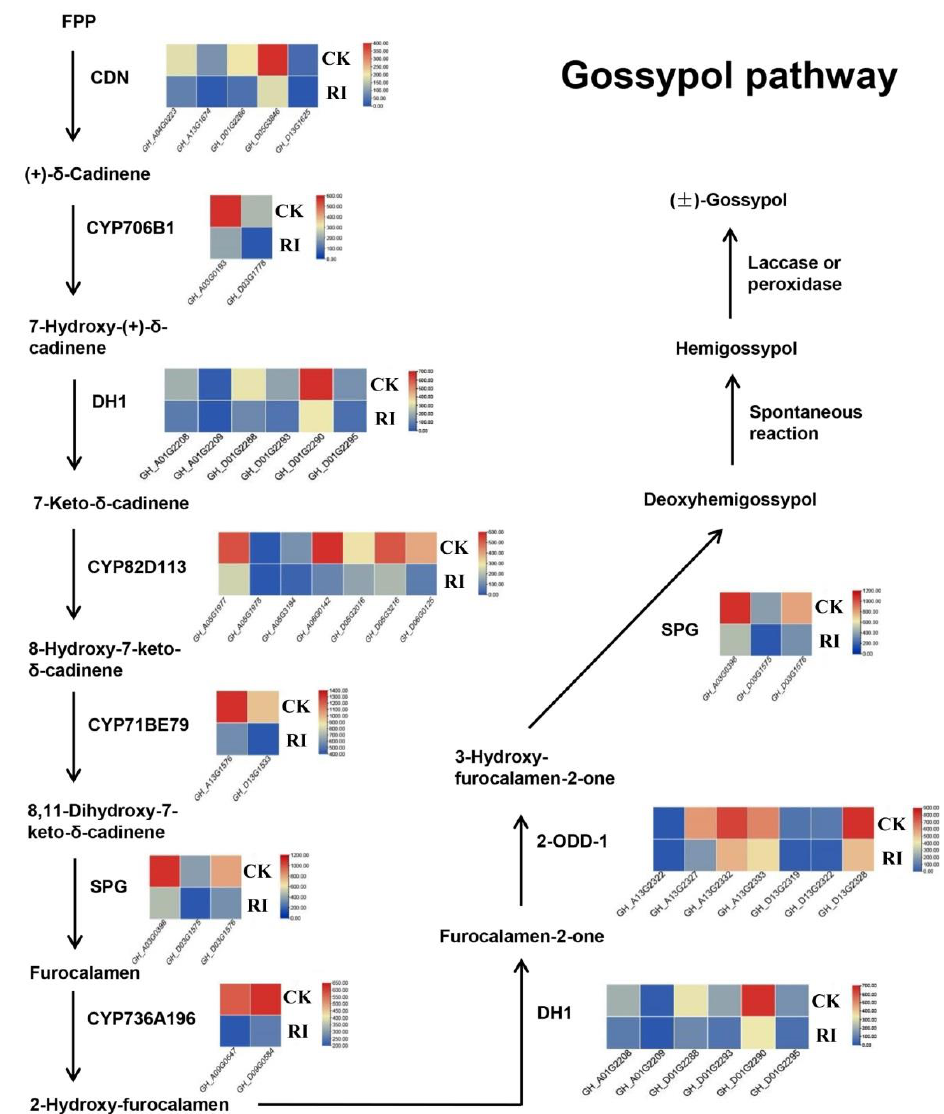
Figure 5. The significantly downregulated genes of the gossypol biosynthesis pathway under root illumination. The expression heatmap indicates the expression of the significantly downregulated genes under root illumination (RI). The color scale is located at the right, the color indicates the average Fragments Per Kilobase per Million (FPKM) of three replication, and significance is set at padj < 0.05.